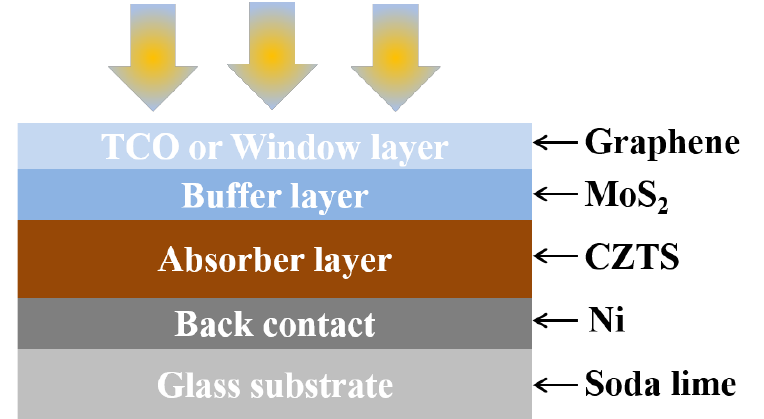
Figure 1. The CZTS-based solar cell structure.